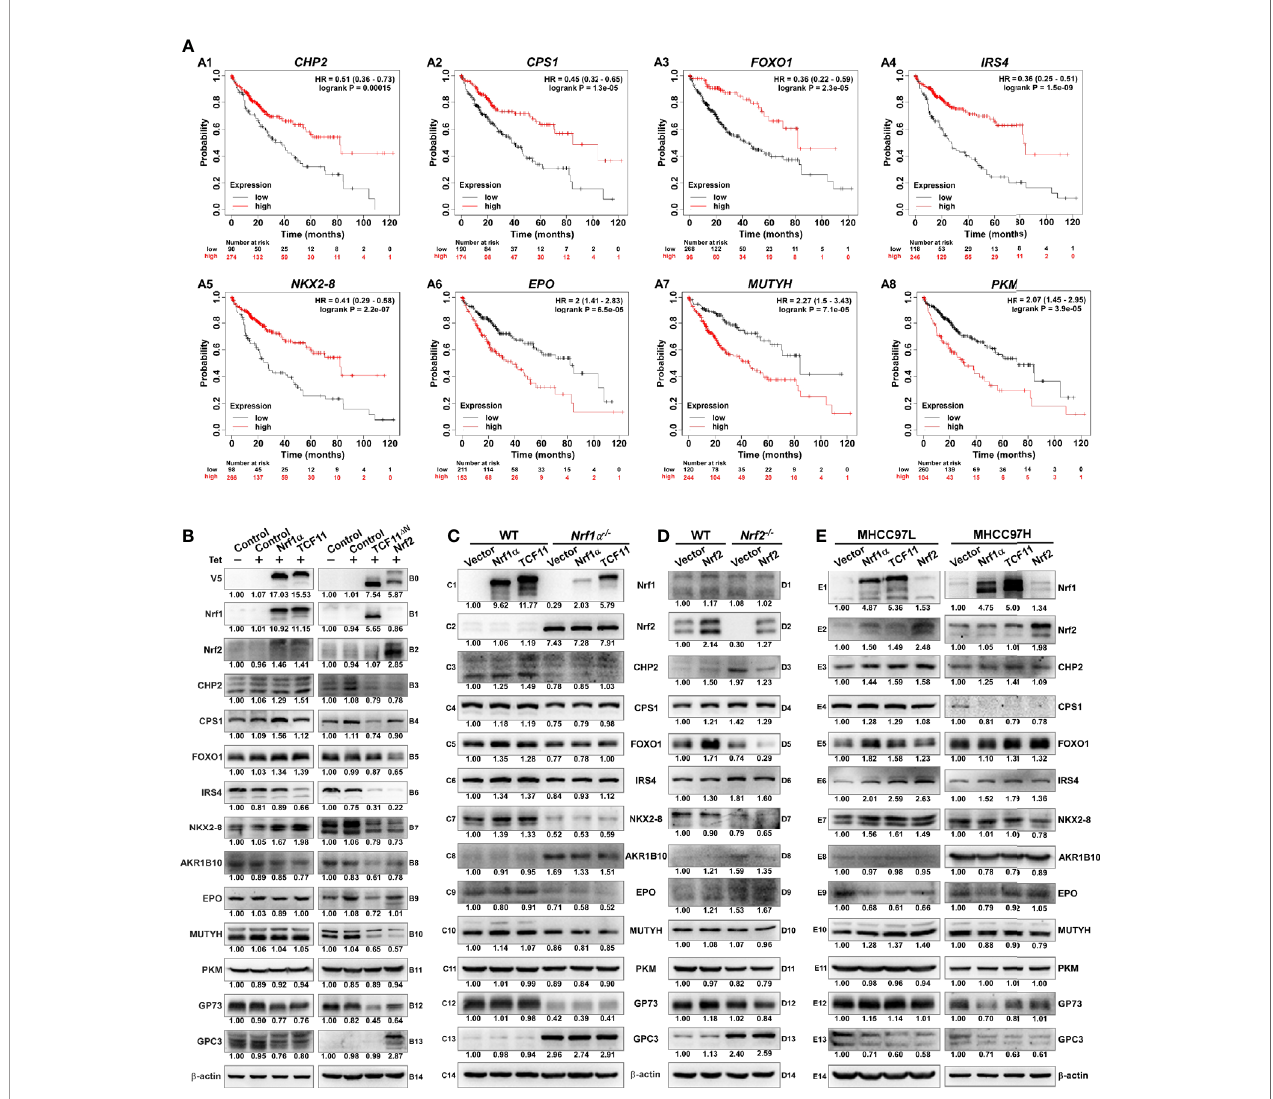
FIGURE 8 | Diverse effects of Nrf1 and Nrf2 on those HCC-relevant proteins that are signi fi cantly correlated with the overall survival (OS). (A) The correlation analysis between of hepatocellular carcinoma (HCC) associated genes and the relevant OS rates of patients with HCC. (B) The protein expression levels of HCC-associated proteins in Nrf1 a , TCF11 , TCF11 D N and Nrf2 cell models were examined by Western blotting analysis of these experimental cell lines that had been induced with or without 1 m g/ml Tet for 12 h before being harvested. (C) Both wild type HepG2 and its derived Nrf1 a − / − cells were transfected with either Nrf1 a or TCF11 expression plasmids, and then allowed for 24-recovery from transfection in the fresh medium before being subjected to Western blotting, to identify the protein levels of HCC- associated proteins. (D) Both wild type HepG2 and its derived Nrf2 − / − cells were transfected with an Nrf2 expression plasmid, and then allowed for 24-recovery from transfection in the fresh medium before being subjected to Western blotting. (E) MHCC97L or MHCC97H cells were transfected with each of Nrf1 a , TCF11 and Nrf2 expression constructs, and then allowed for 24-recovery from transfection in the fresh medium before being examined by Western blotting to identify abundances of HCC-associated proteins as described above. The intensity of all the immunoblots was calculated and shown on the bottom (B – E)